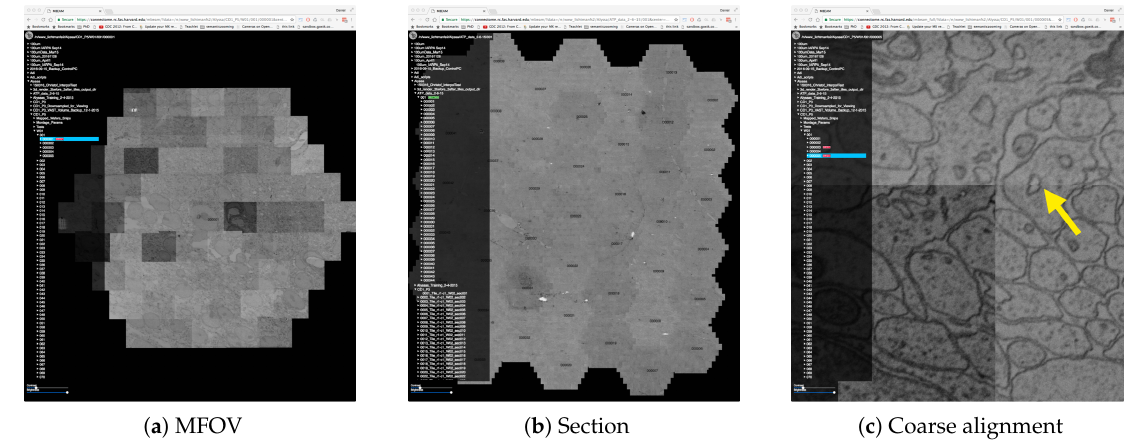
Figure 3. The MBeam viewer visualizes data during image acquisition using the Zeiss MultiSEM 505 electron micoscope. ( a ) An individual multi-beam field-of-view (MFOV) is visualized, consisting of 61 images which are coarsely aligned using coordinates from the microscope. Each individual image is 3128 × 2724 pixels in size, resulting in roughly 30 k × 26 k pixels for each MFOV. Multiple MFOVs are stitched together as one section within an image volume. The MBeam viewer visualizes such sections with possibly hundreds of MFOVs. ( b ) 44 MFOVs stitched to roughly 200 k × 170 k pixels. Demand-driven rendering and on-the-fly mip-mapping enable user interaction in realtime. ( c ) The zoomed-in view shows the full resolution of the data and stitching artifacts due to coarse alignment (yellow